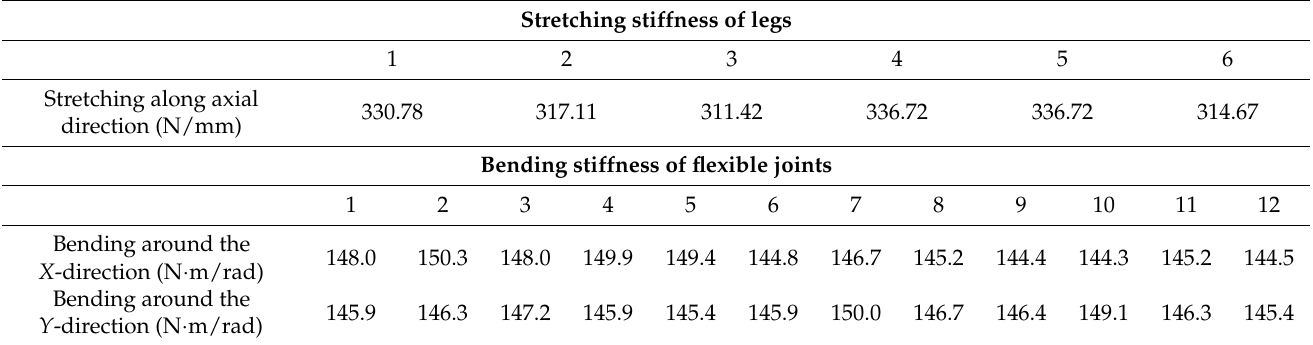
Table 3. Stiffness values of flexible components obtained from the tests.